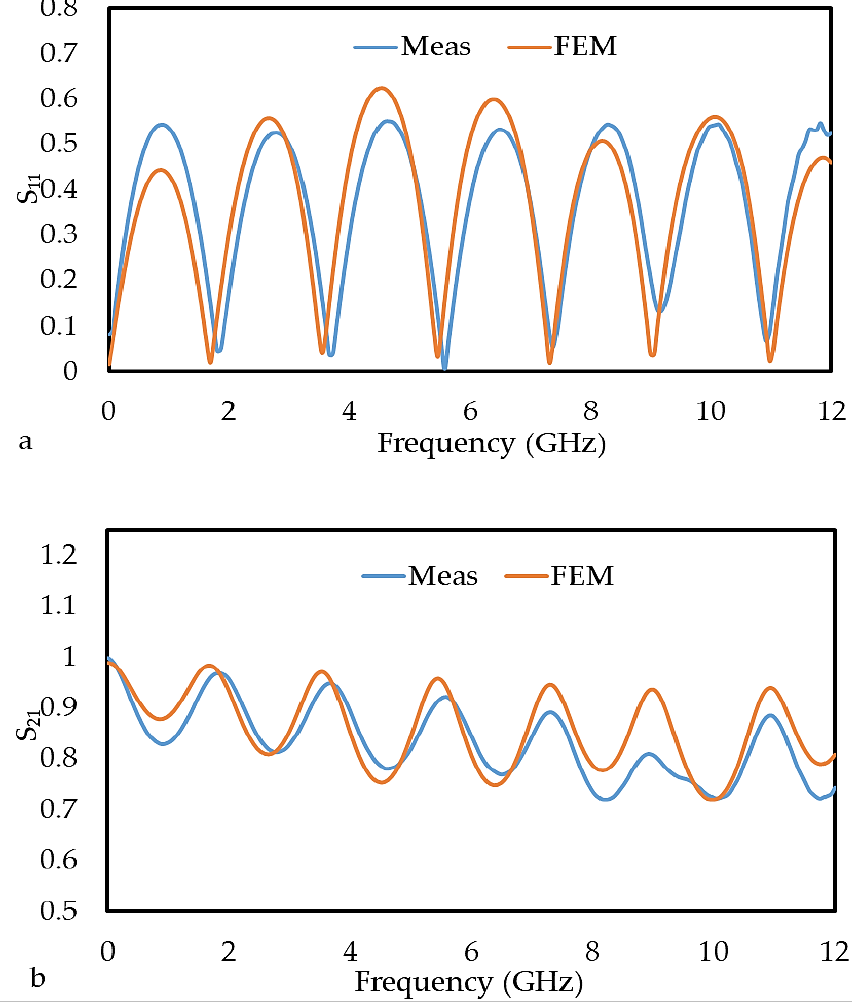
Figure 14. The magnitudes of ( a ) S 11 and ( b ) S 21 for both the measurement and FEM simulation method of the unloaded microstrip line.